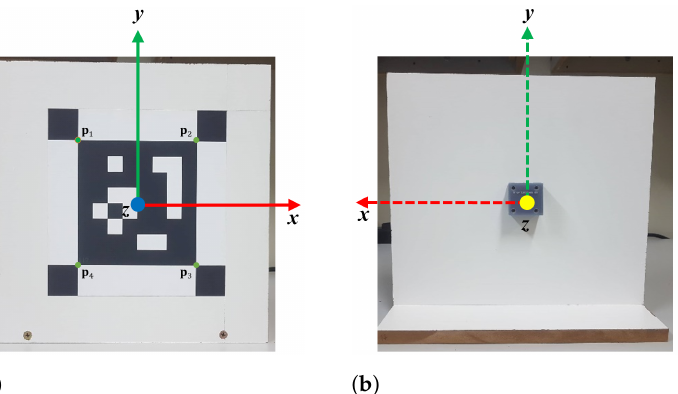
Figure 6. Smart marker: a square planar fiducial marker in front ( a ); and an embedded pose measurement system (PMS) unit with their coordinates systems at the back ( b